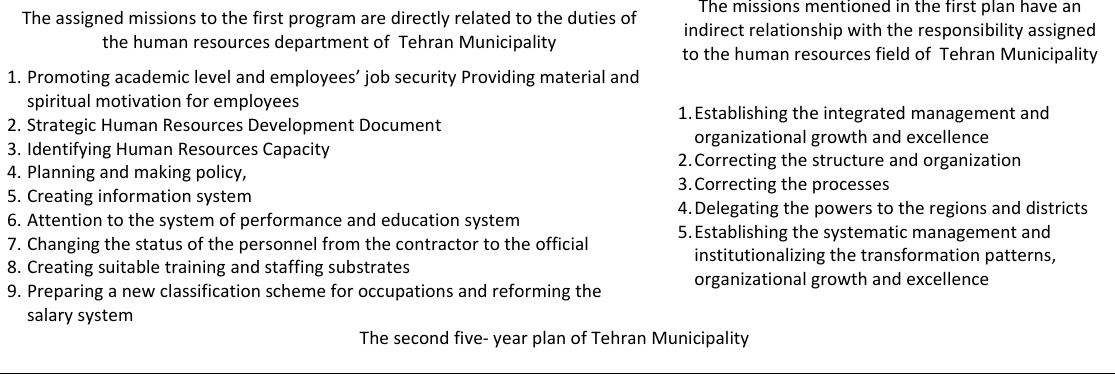
Table 5. The first five- year plan of Tehran Municipality (2009- 2014